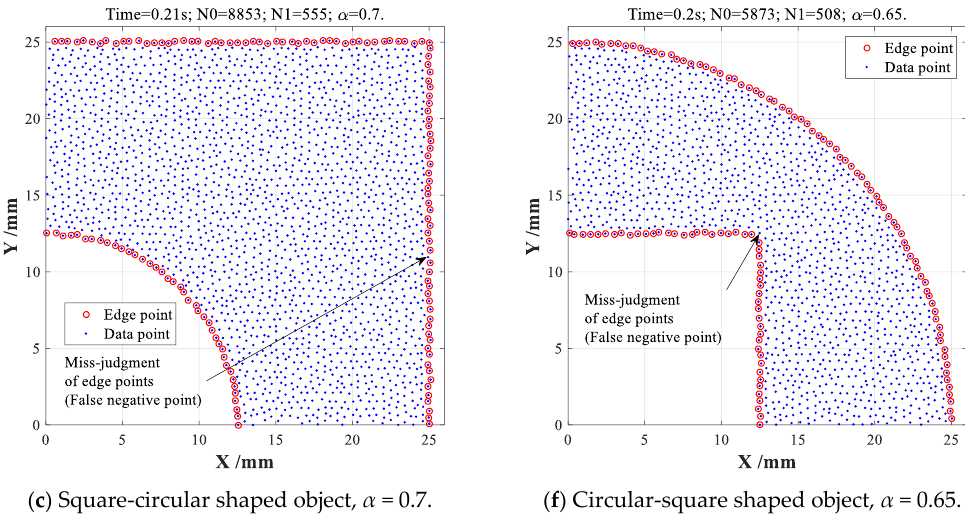
( f ) Circular-square shaped object, α = 0.65. Figure 6. Boundary extractions on two different point cloud datasets with α -shape method.